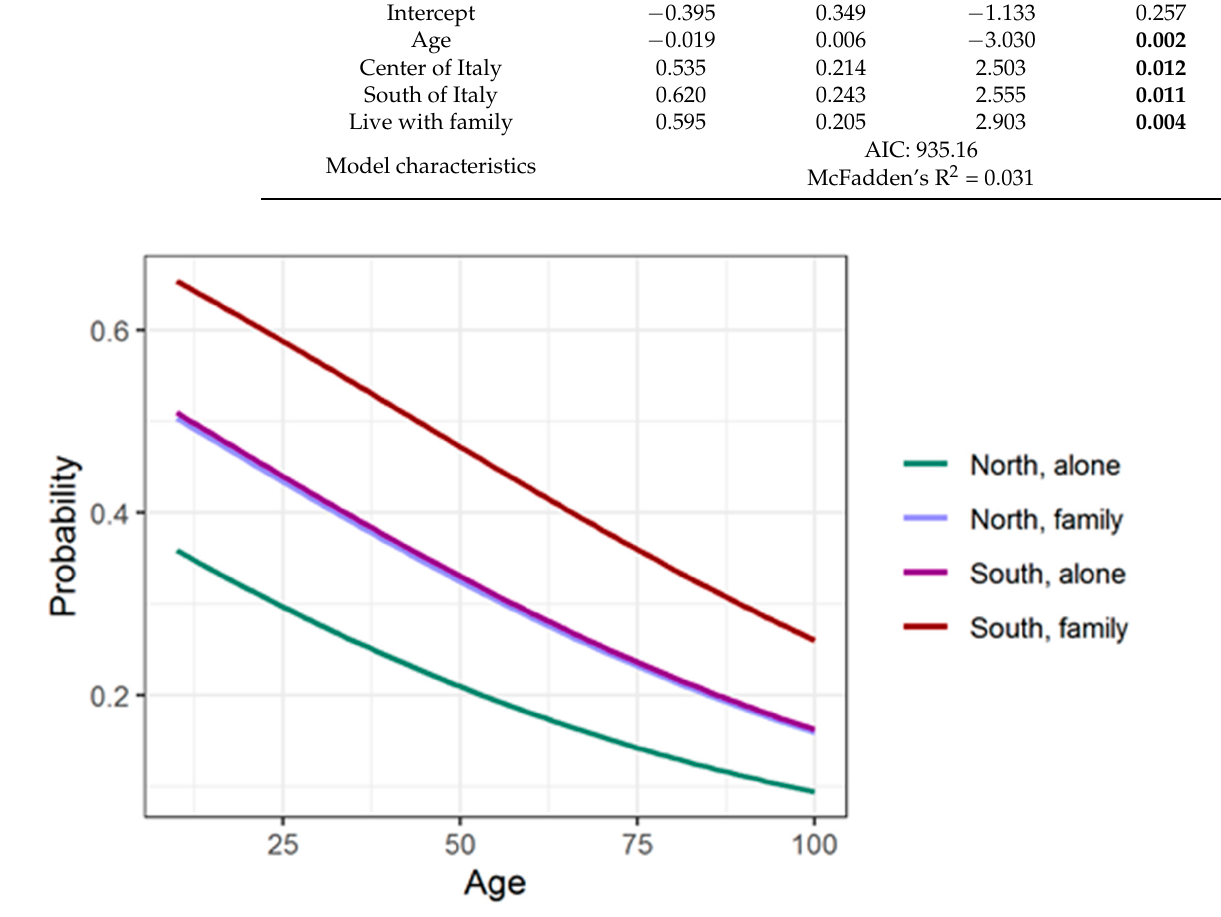
Figure 2. Probability response curves for introducing of cariogenic food. Curves “North, family” and “South, alone” almost coincide.